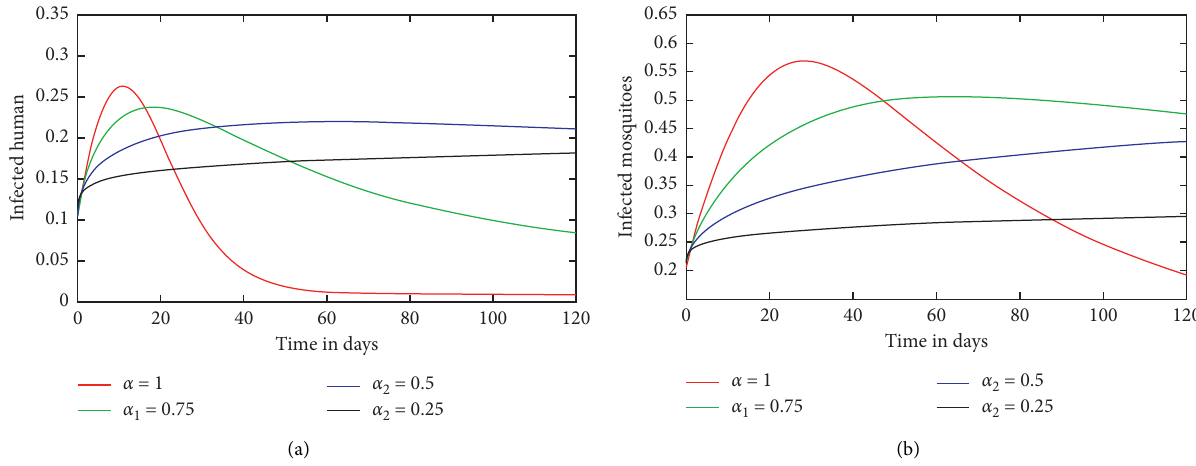
Figure 4: Variations of infected population at α � 1, 0.75, 0.50, and 0.25: (a) infected human; (b) infected